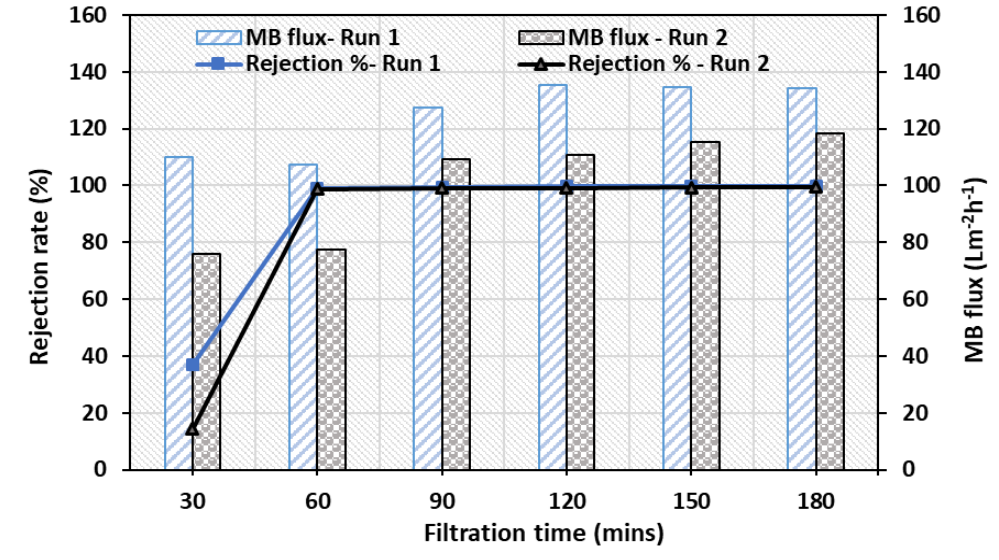
Figure14. Permeationandrejectione ffi ciencyoftheZnO-MoS 2 Figure 14. Permeation and rejection efficiency of the ZnO-MoS 2 PCM for two subsequent filtration cycles.